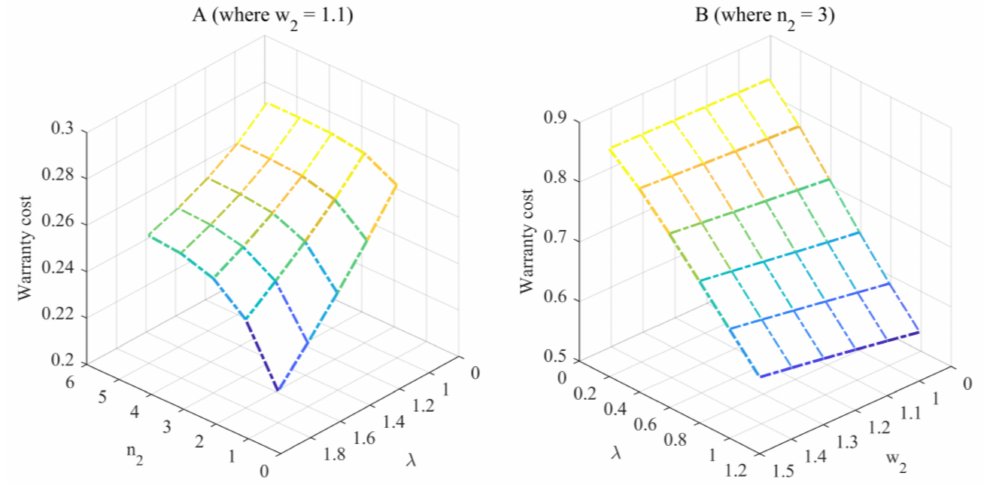
Figure 2. How n 2 , w 2 , and λ affect the two-stage